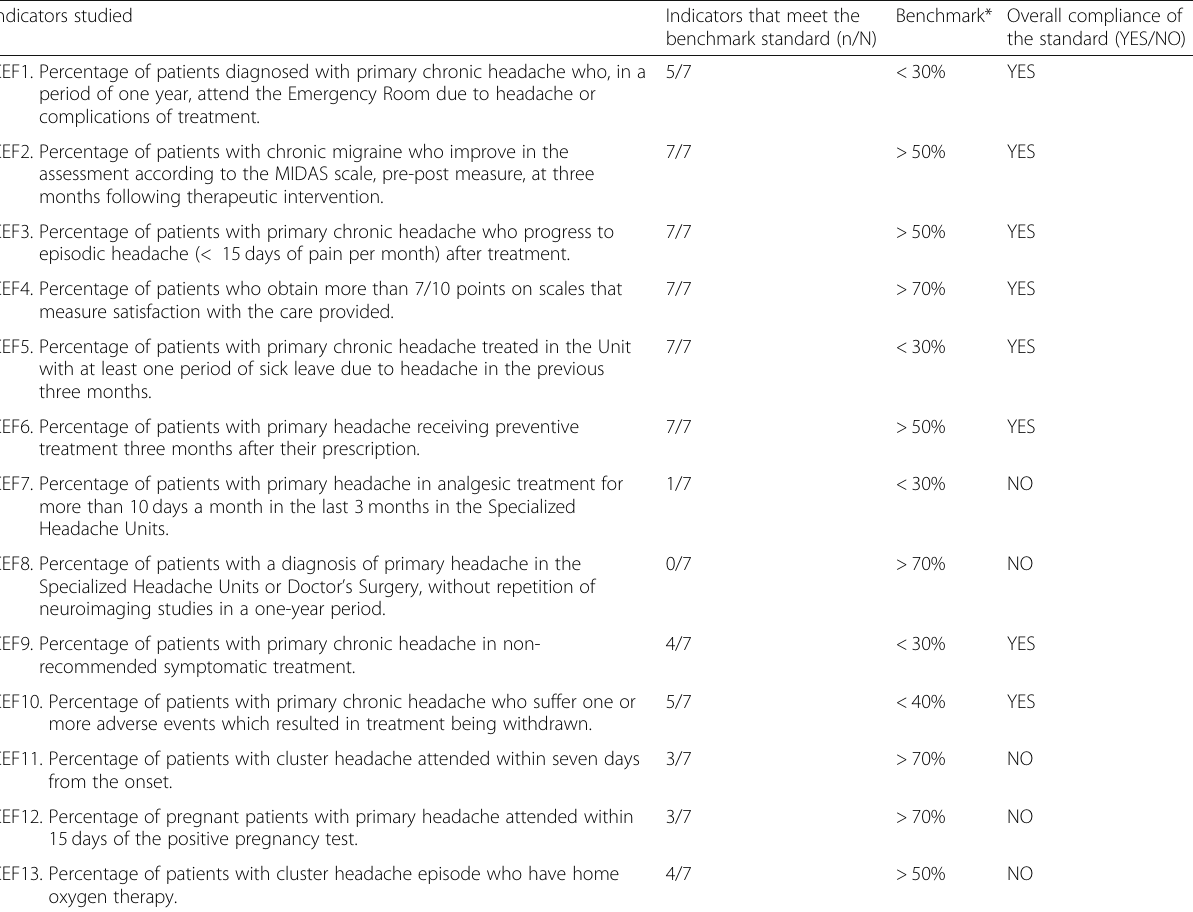
Table 4 Level of compliance with standards for the indicators assessed Indicators